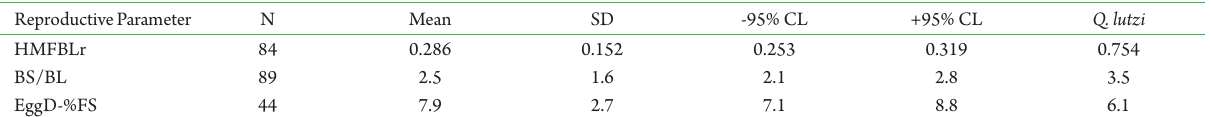
Table 4. Number of species (N) to which Quadrivisio lutzi was compared; their mean, standard deviation (SD) and 95% confidence limits (CL) of the reproductive